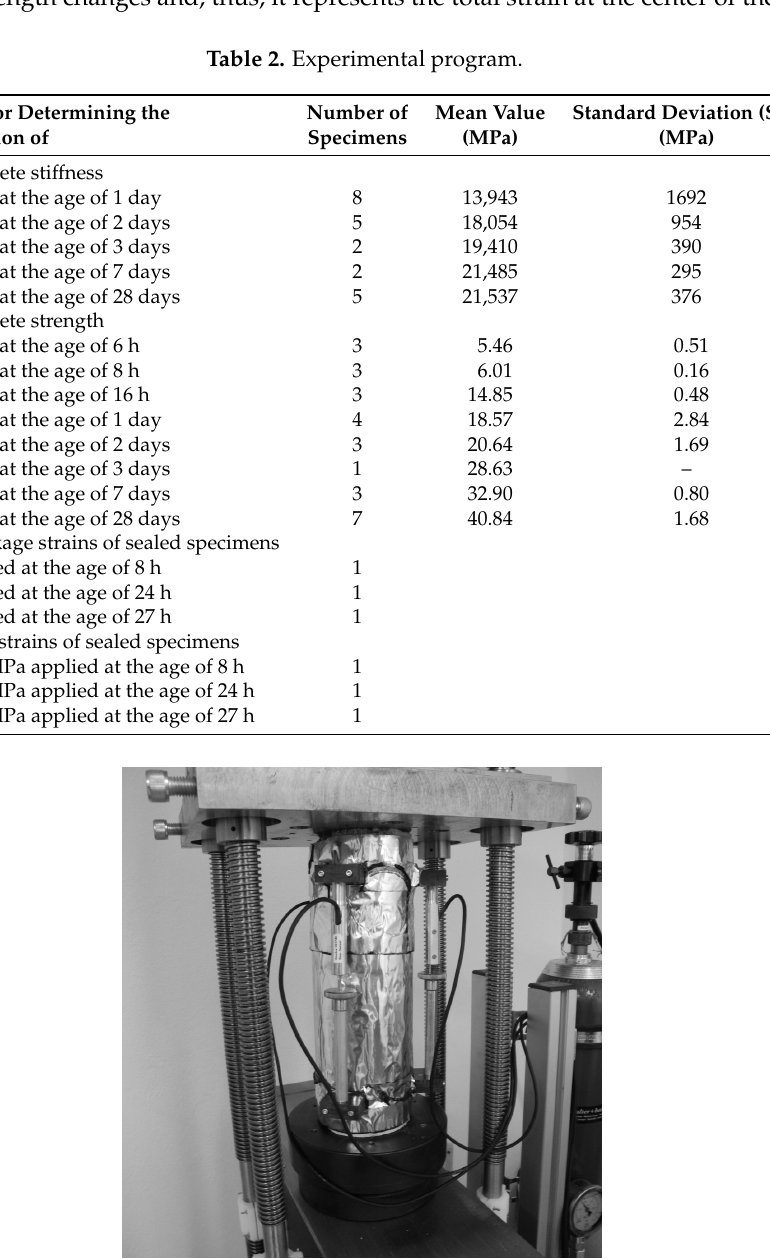
Figure 2. Sealed specimen in the creep test bench with displacement transducers fixed to the